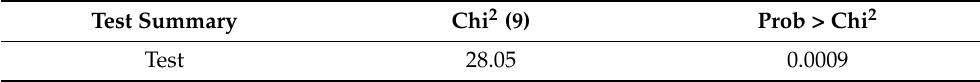
Table 7. Statistics of Hausman test